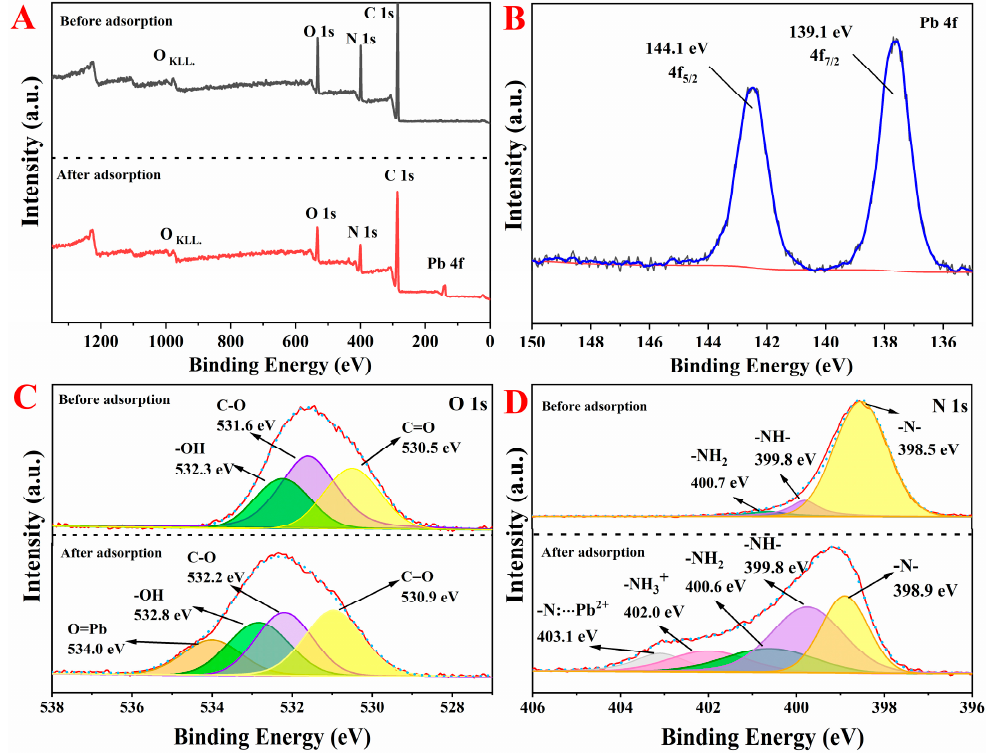
Figure 8. Wide-scan XPS spectra of PPEA 0.1 before and after the adsorption ( A ), Pb 4f binding energies ( B ), O 1s binding energies ( C ), and N 1s binding energies ( D ).